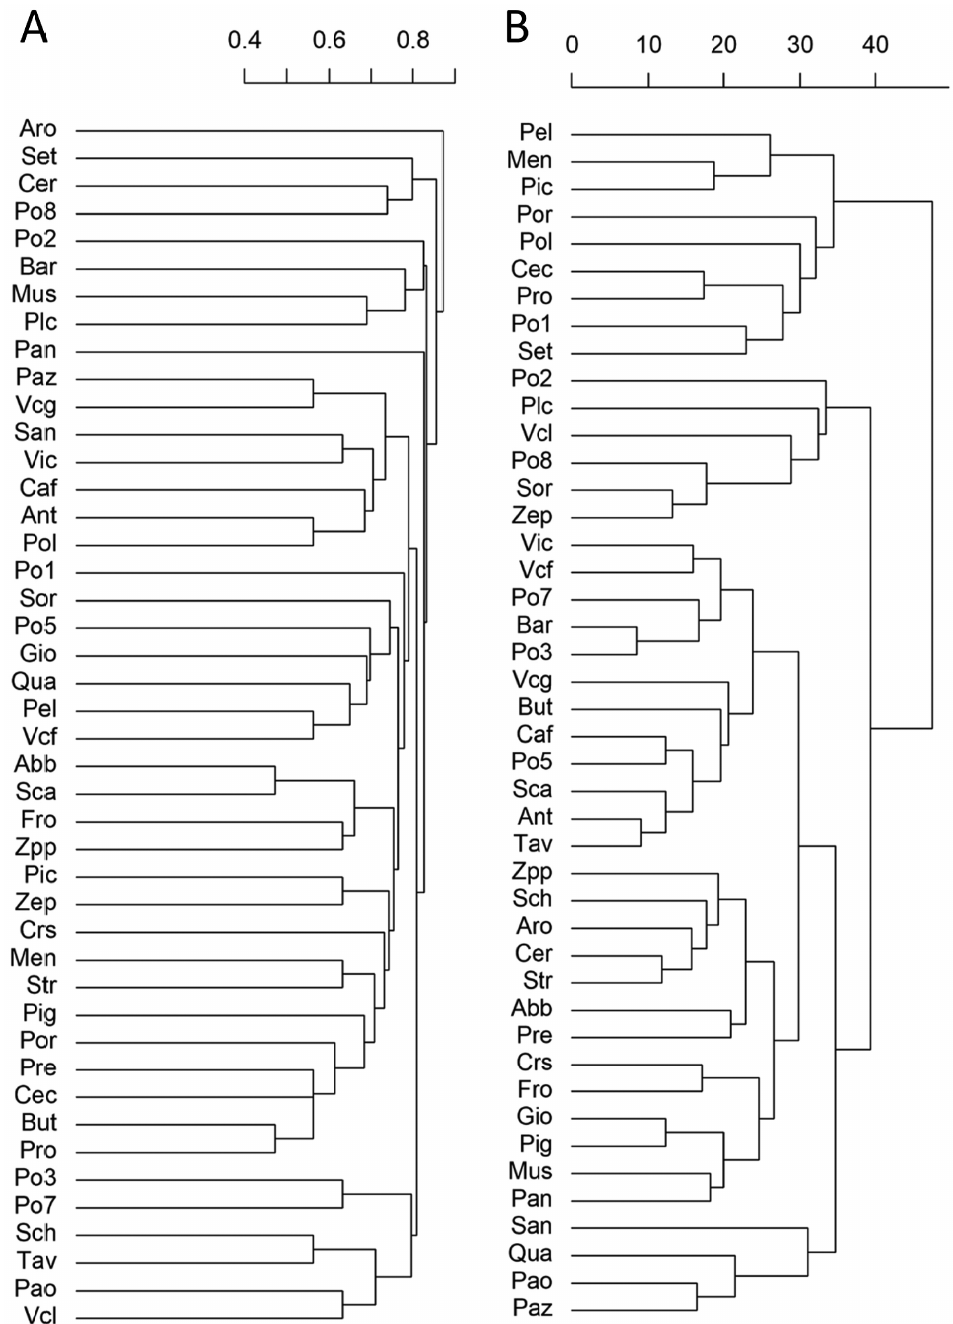
Figure 2. Cluster analysis of the landraces based on the phenotypic traits. ( A ) Dendrogram of the 44 apricot landraces based on 16 qualitative traits. ( B ) Dendrogram of the 44 apricot landraces based on 16 quantitative traits. The full name of the landraces is reported in Table